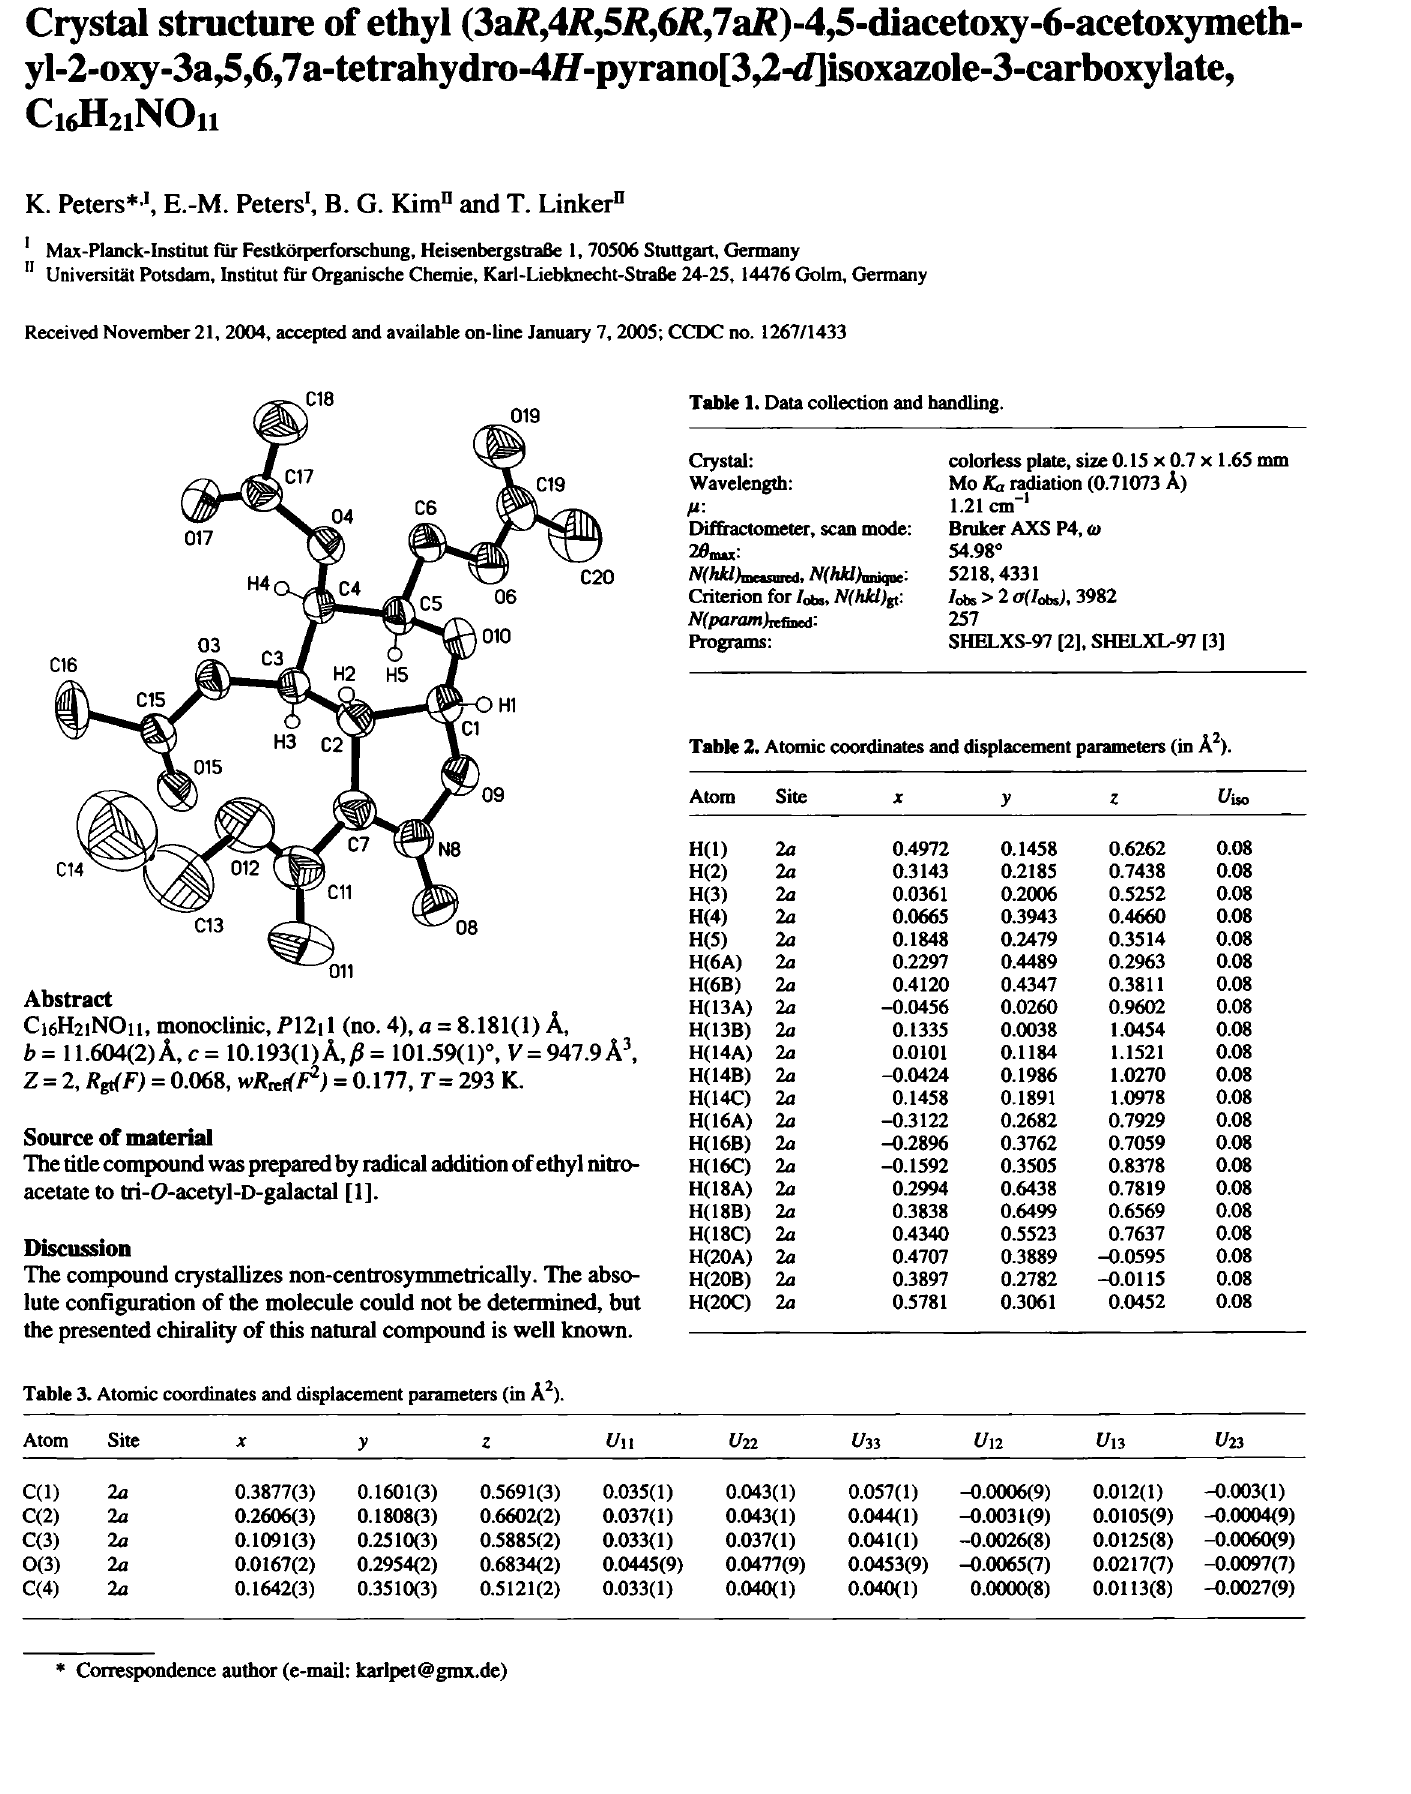
Table 1. Data collection and handling.